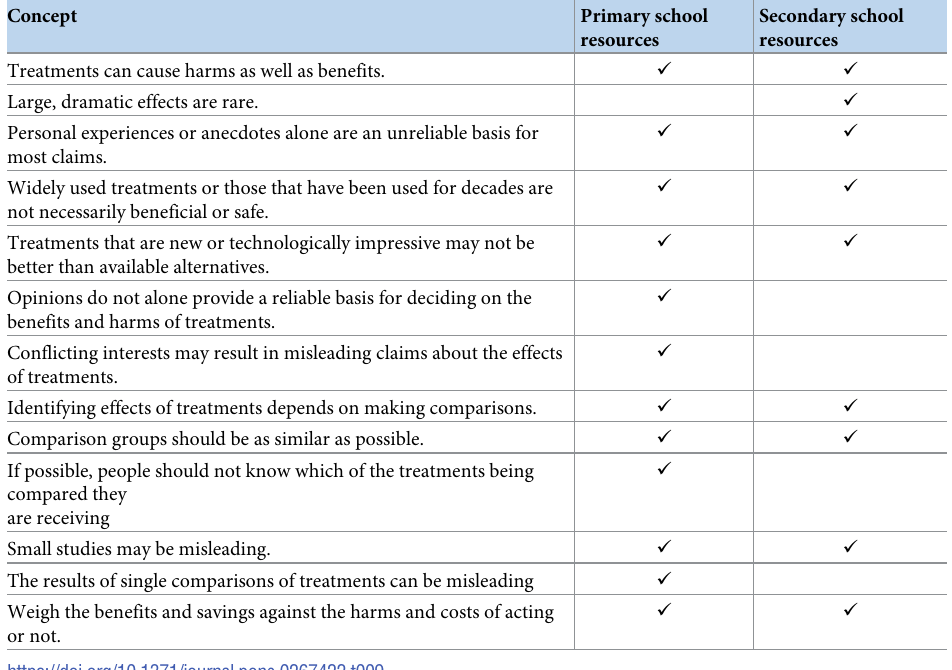
Table 9. Comparison of concepts in the IHC primary and secondary school resources.